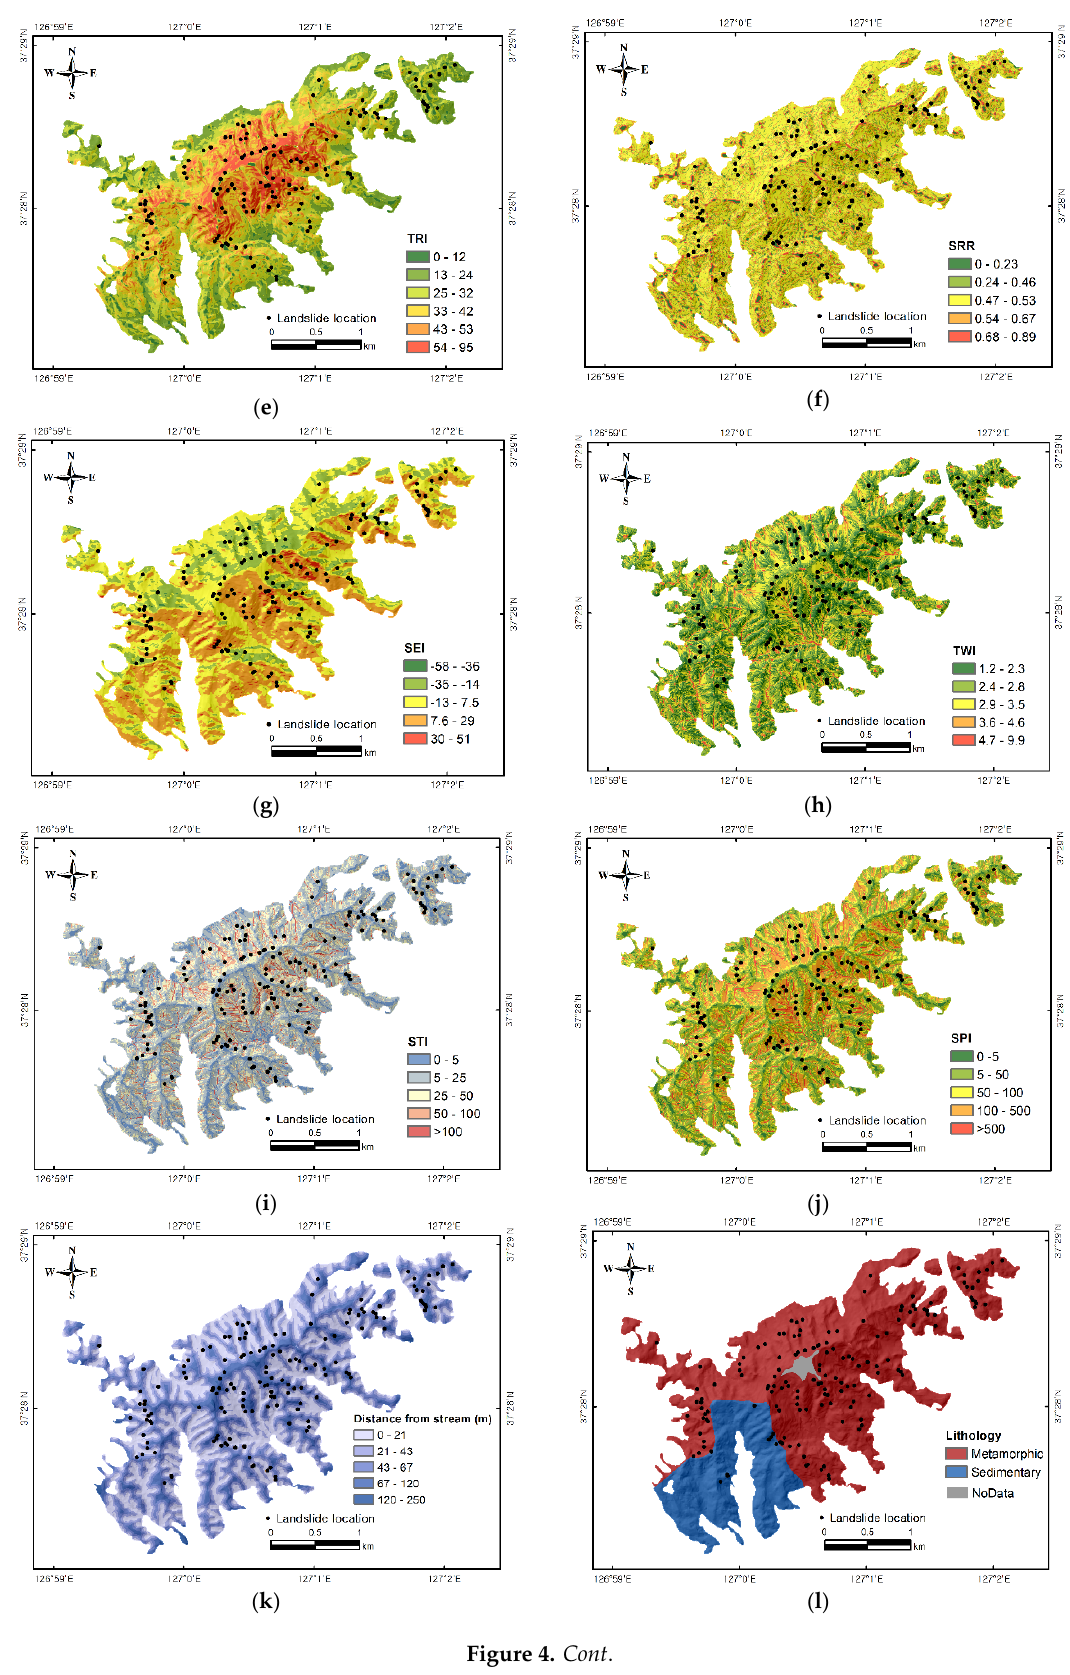
Figure 4. Cont Figure 4. Continued.